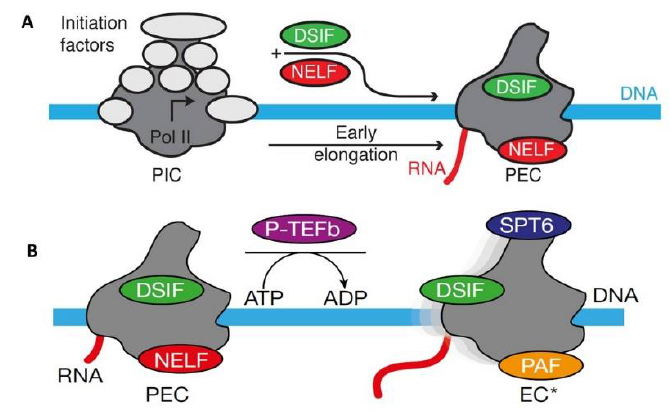
Figure 2. Pause and go of RNA polymerase II during transcription. ( A ) Schematic of conversion of the RNAPII pre-initiation complex (PIC) to a promoter proximally paused RNAPII-DSIF-NELF elongation complex (PEC) [33]. ( B) Schematic showing conversion of the paused PEC to the activated RNA Pol II-DSIF-PAF-SPT6 elongation complex (EC*). SPT6, homolog of yeast s u p pressor of T y 6 (adapted from references [33,34], with permission from Dr. Patrick Cramer, Max Planck Institute for Biophysical Chemistry, Germany).